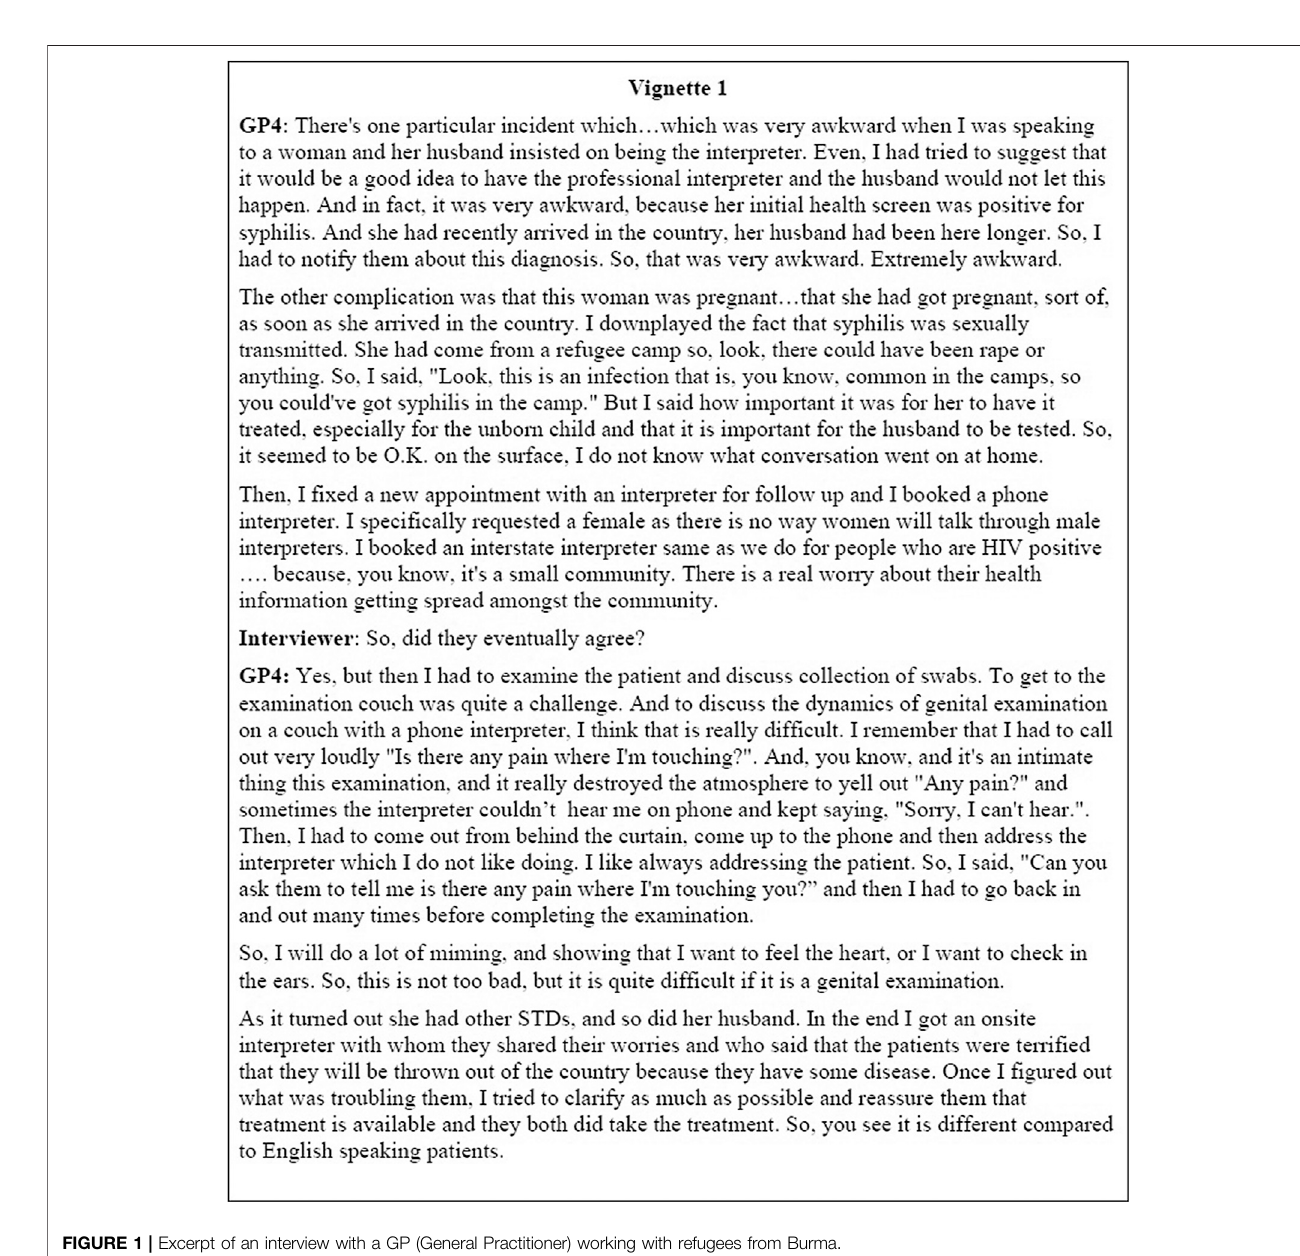
Frontiers in Communication |